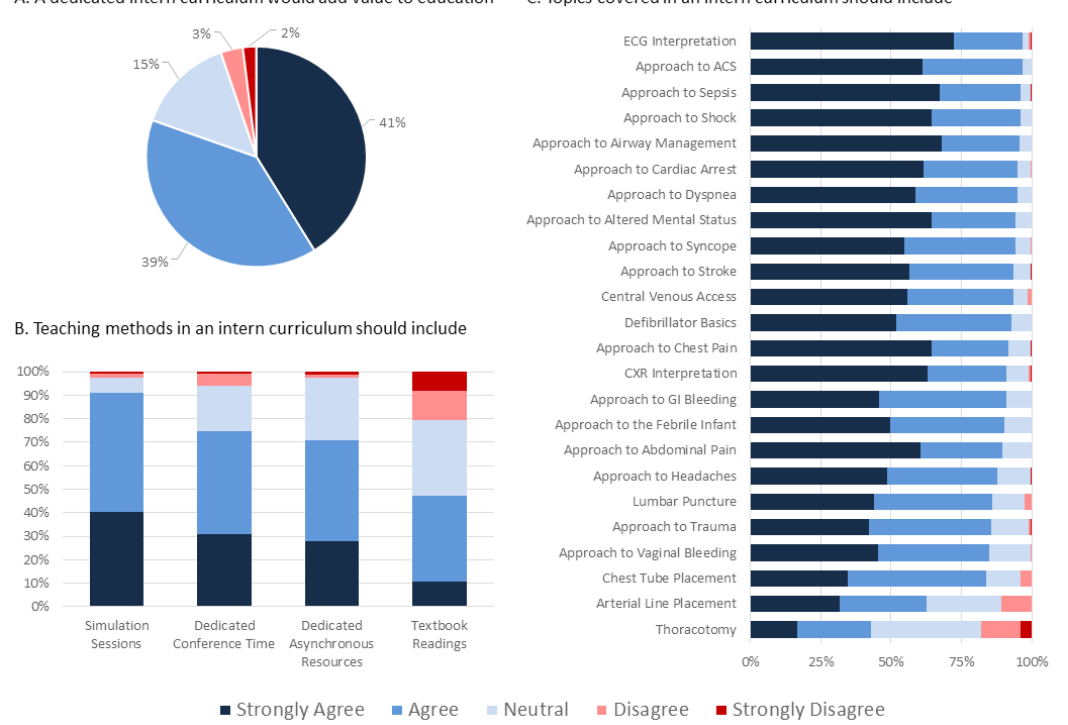
Figure ABC. Emergency medicine resident opinions on intern curriculum value and design. ECG , electrocardiogram; ACS, acute coronary syndromes; CXR , chest radiograph; GI,